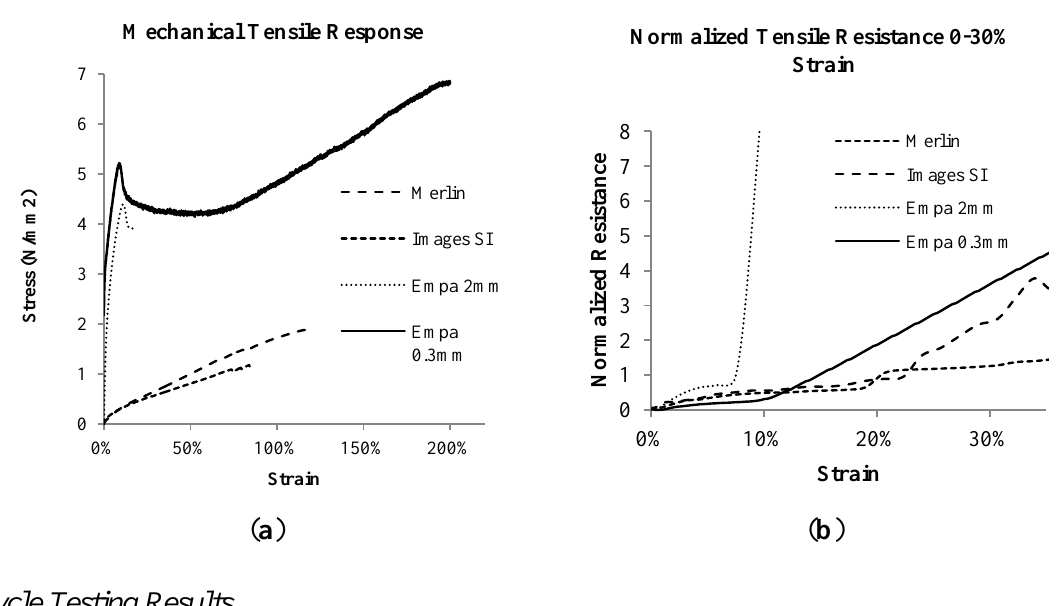
Figure 2. ( a ) Stress-strain tensile response of the monofilaments and ( b ) normalized resistance-strain response from 0%–30%